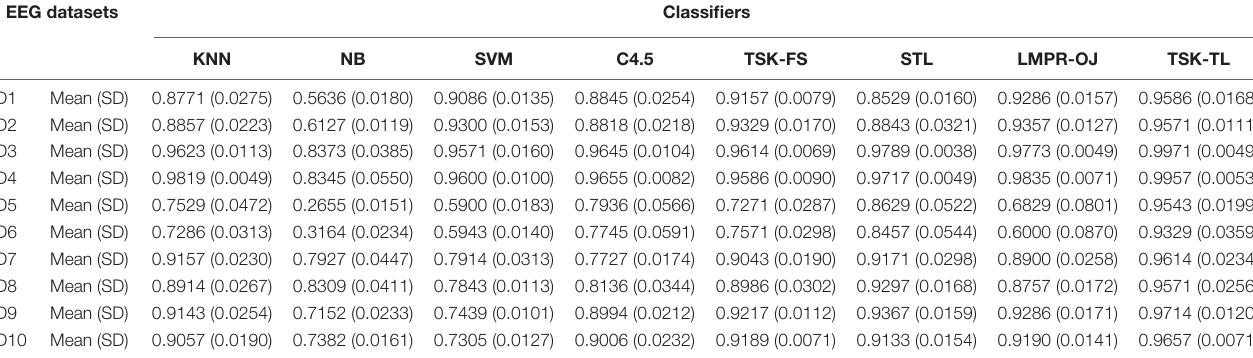
TABLE 5 | Experimental results of eight classifiers in the STFT view.